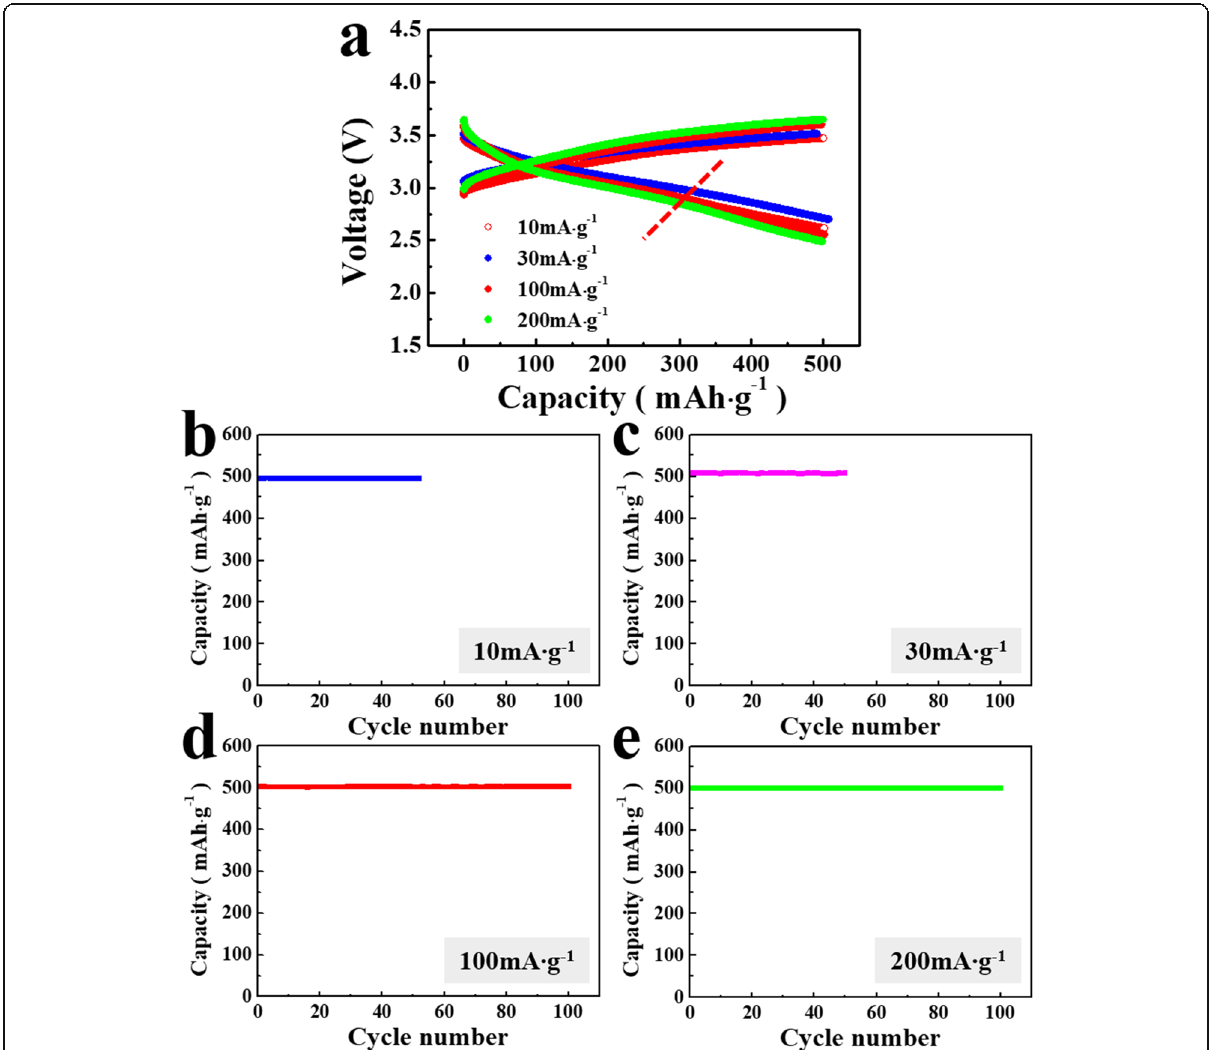
Fig. 3 Voltage profile and cyclic performance of the lithia/Li 2 RuO 3 nanocomposites at current densities of 10, 30, 100, and 200 mA g − 1 with limited capacity of 500 mAh g − 1 . a Voltage profile; cyclic performance at b 10 mA g − 1 , c 30 mA g − 1 , d 100 mA g − 1 , and e 200 mA g −